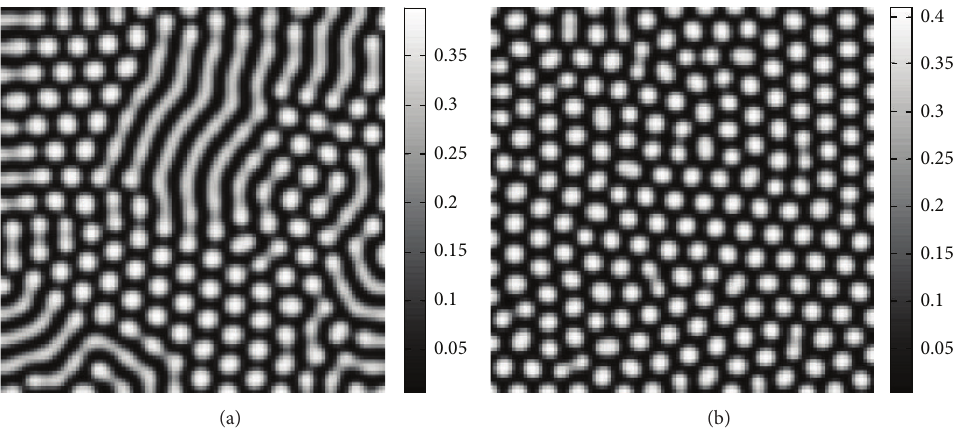
Figure 4: Pattern formation of the prey 𝑢 of model (3) with 𝑞 1 = 0.6 , 𝑐 1 = 2.1 (a) and 𝑐 1 = 2.21 (b). Iterations: (a) 100000 and (b) 20000 .